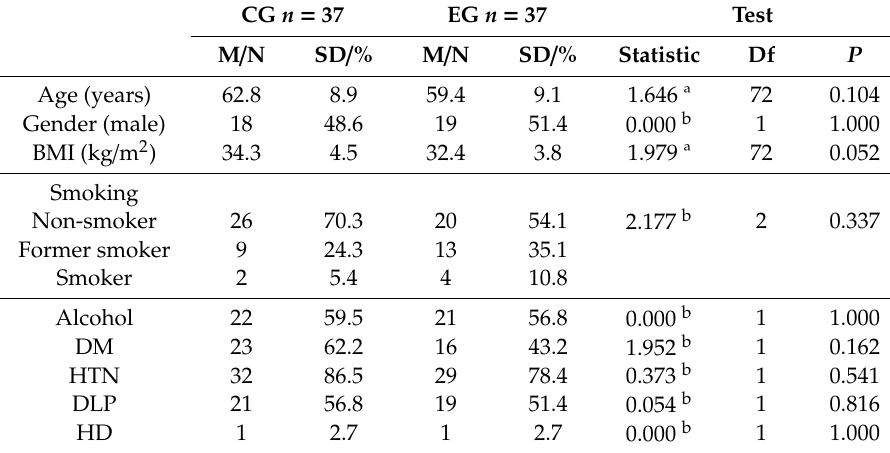
Table 1. Age, gender, BMI, and clinical history prior to